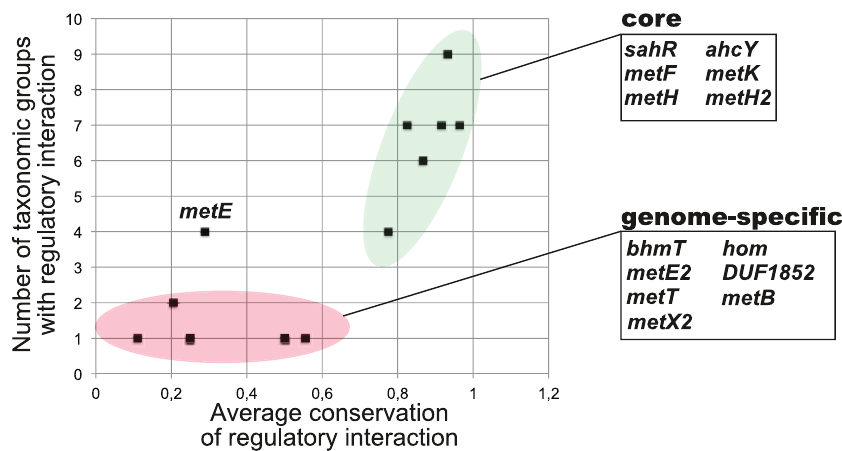
Figure 4. Conservation of regulatory interactions in the reconstructed SahR regulons. The core regulon, taxon- and genome-specific regulon members are highlighted and listed along with their average conservation scores and functional annotations in Table S2.